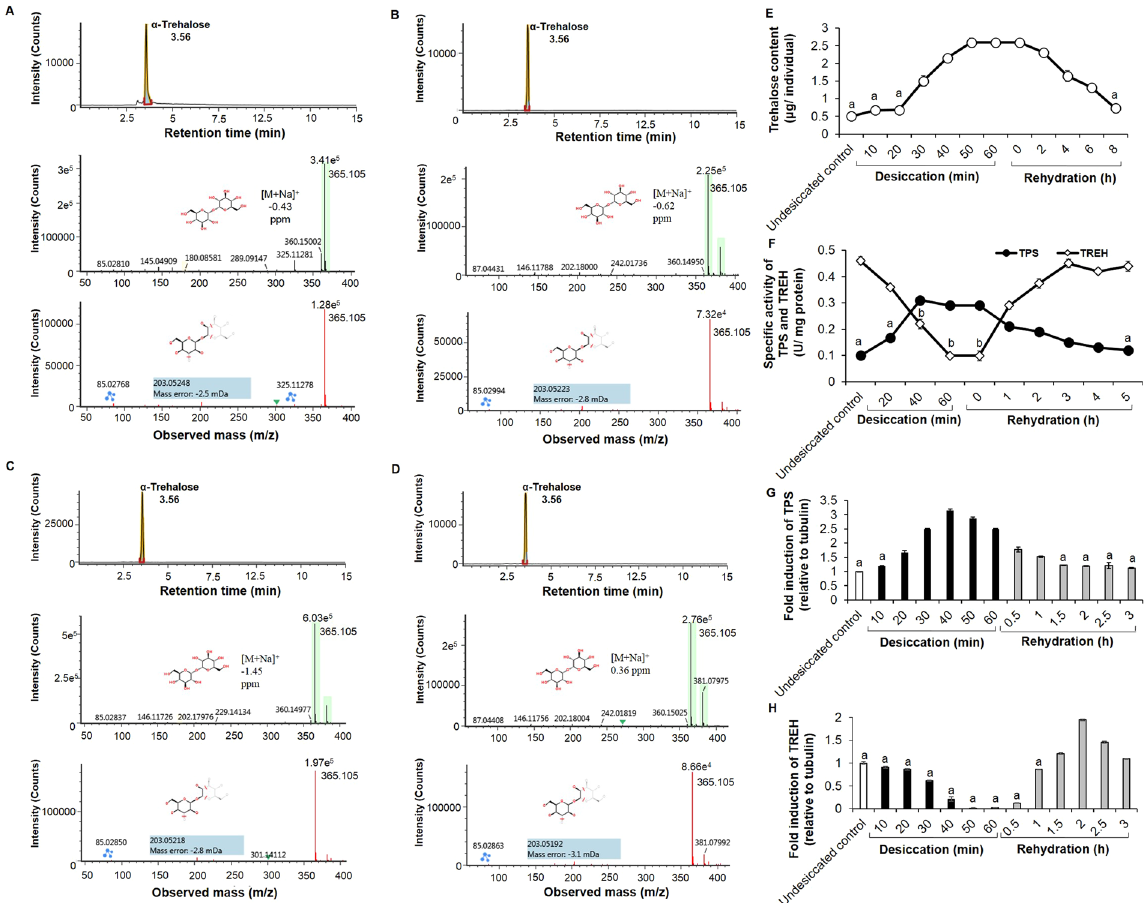
Figure 2. Desiccation-induced trehalose synthesis in the larvae. ( A–D ) Representative UPLC-QToF-MS chromatograms indicating the detection of trehalose in the midge larvae. Trehalose was identified as [M + Na] + adduct with mass accuracy − 0.43 ppm with confirmatory ions (203.05248 Da, 145.04906 Da and 85.02768 Da). ( A ) Standard trehalose solution. ( B ) Undesiccated control ( C ) 50 min desiccation. ( D ) 5 h rehydration. ( E ) High trehalose content was prominent during desiccation exposure followed by rapid decline upon rehydration. Data represented are mean ± SD of three replicates (a = p < 0.05 vs 50 min desiccation). ( F ) TPS and TREH enzyme activities (U/mg protein) during desiccation and rehydration. Data represented are mean ± SD of three replicates (a = p < 0.05 vs 40 min desiccation for TPS; b = p < 0.05 vs 3 h rehydration for TREH). ( G ) Fold induction of tps transcripts during desiccation and rehydration. Data represented are mean ± SD of three replicates (a = p < 0.05 vs 40 min desiccation). Undesiccated control values were set to 1 against which all other values were compared. The results were represented as fold induction relative to tubulin. ( H ) Fold induction of treh transcripts during desiccation and rehydration. Data represented are mean ± SD of three replicates (a = p < 0.05 vs 2 h rehydration). Undesiccated control values were set to 1 against which all other values were compared. The results were represented as fold induction relative to